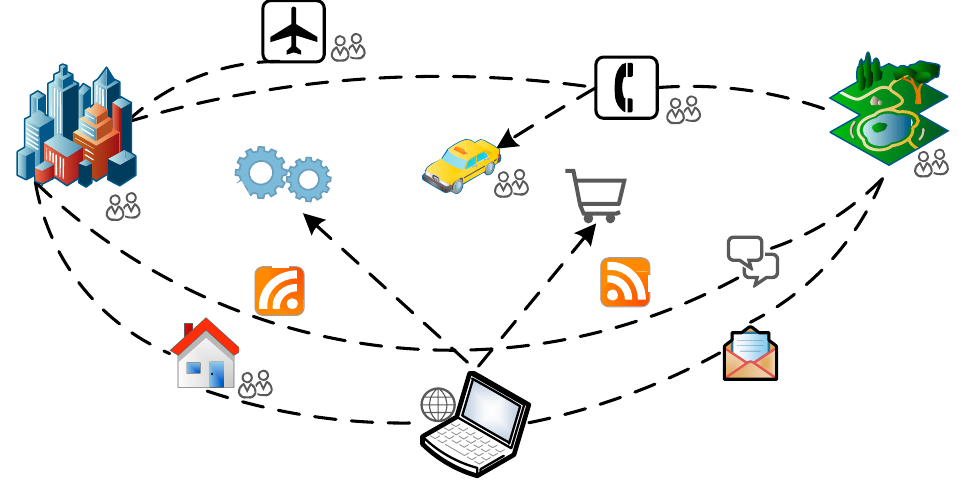
Figure 1. Smart tourism using the IoT.